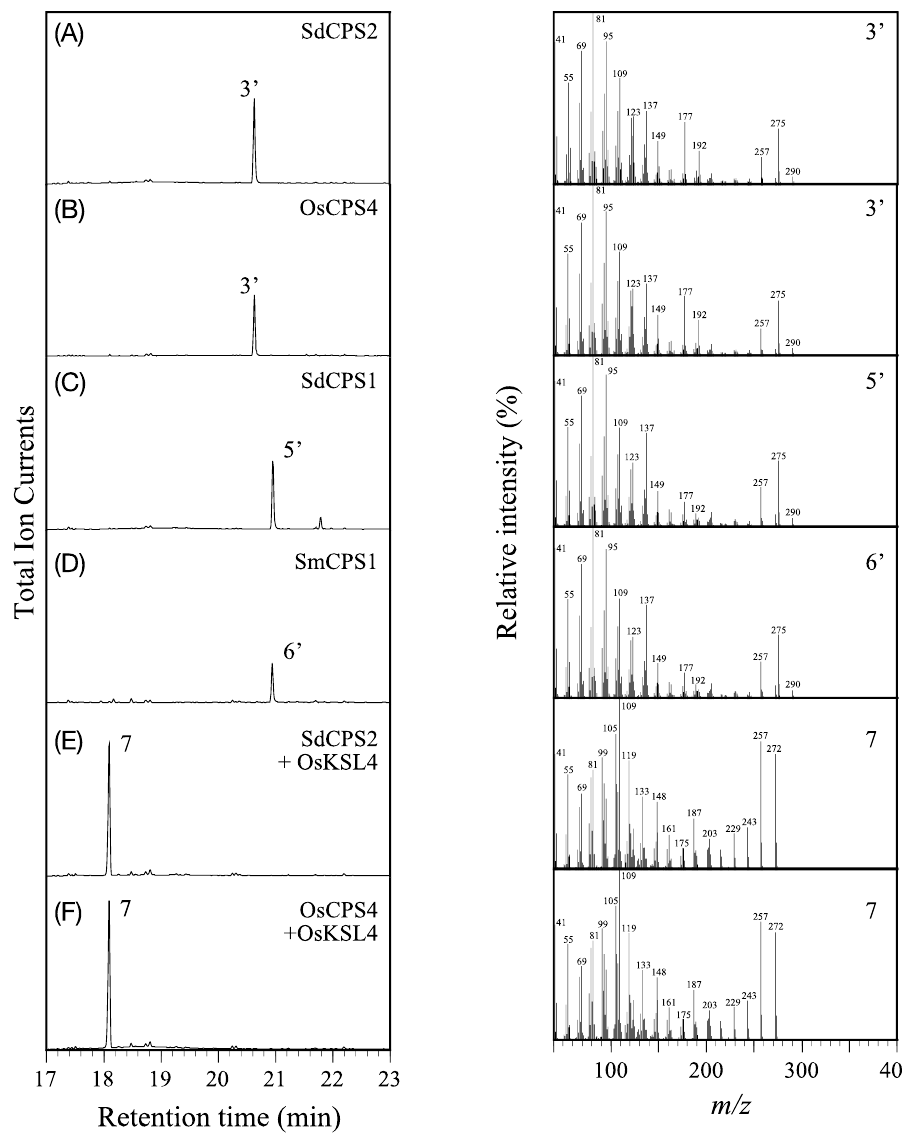
Figure 2. GC-MS analyses of extracts from cultures expressing the indicated gene products. Shown are total-ion-count (TIC) chromatograms on the left, and mass spectra for the indicated peak on the right. ( A ) Production of 3 by SdCPS2, observed as the dephosphorylated derivative syn -copalol ( 3 ’ ) produced by endogenous phosphatases. ( B ) Production of 3 by OsCPS4, observed as the dephosphorylated derivative syn -copalol ( 3 ’ ) produced by endogenous phosphatases. ( C ) Production of 5 by SdCPS1, observed as the dephosphorylated derivative ent- copalol ( 5 ’ ) produced by endogenous phosphatases. ( D ) Production of 6 by SmCPS1, observed as the dephosphorylated derivative normal -copalol ( 6 ’ ) produced by endogenous phosphatases. ( E ) Production of 7 by SdCPS2 and OsKSL4. (F) Production of 7 by OsCPS4 and OsKSL4.